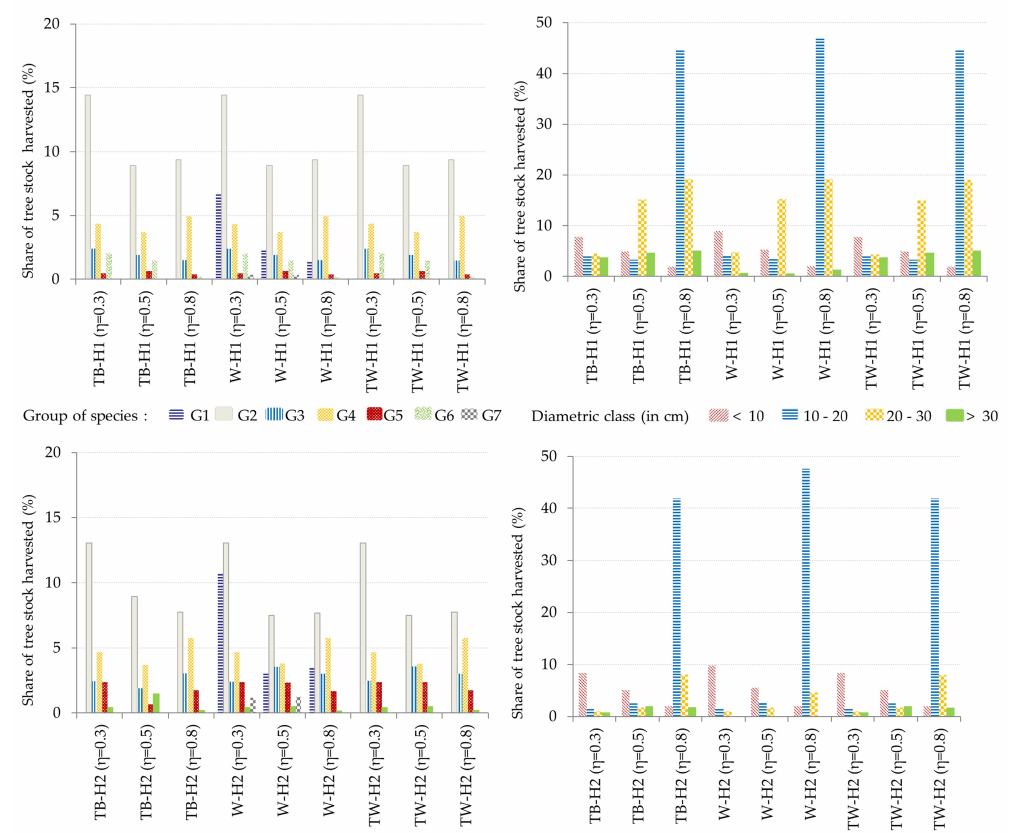
Figure 5. Share of trees harvested for the first and second harvesting period by group of species, size class and optimization scenario (Results for a discount rate 4%, and maximum harvesting rates η of 0.3, 0.5 and 0.8, with TB, W and TW indicating timber revenues maximization, water benefits maximization and joint timber and water benefits maximization, respectively. H k indicates the harvesting period from 1 to 2) (2014